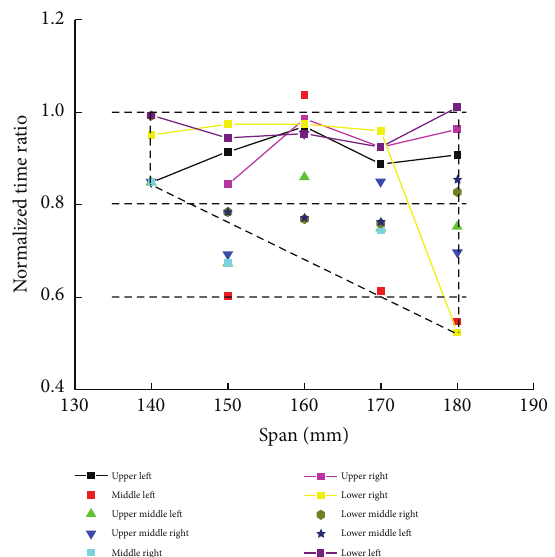
Figure 9: Variation rule of normalized time of feature points with different